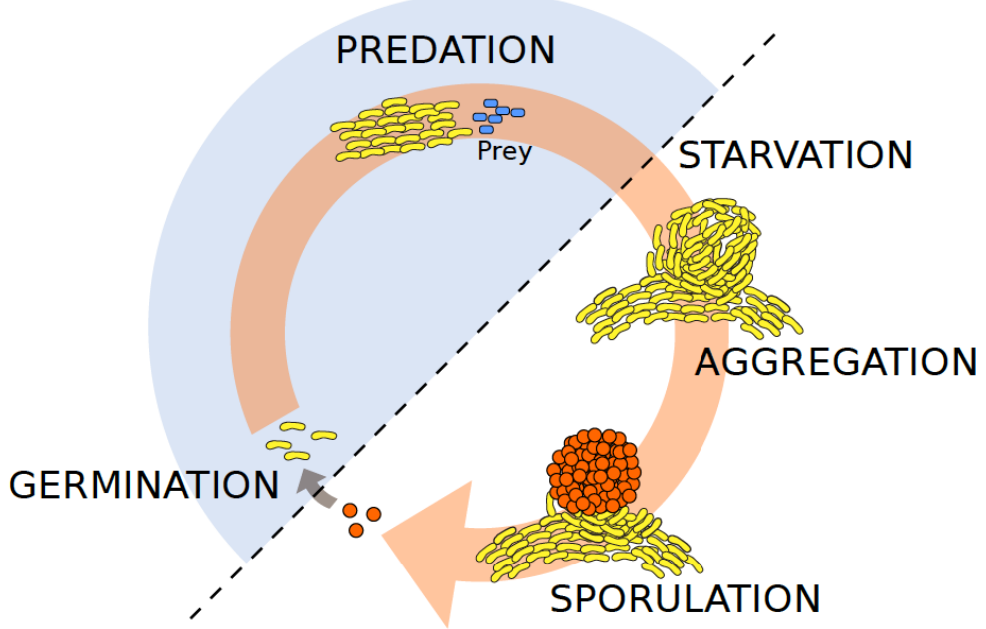
Figure 1. Schematic life cycle of the social myxobacterium Myxoccocus xanthus . The life cycle of M. xanthus (yellow-pigmented rods) is governed by the availability of food sources such as organic compounds or bacterial prey cells (blue rods). Under ambient nutrient-rich conditions, M. xanthus cells engage in group-level predation for feeding and rely on different (both social and solitary) motility systems. It is in this vegetative stage (highlighted as shaded blue half-circle), that cells are most susceptible to phage adsorption, such as shown for Mx1 [34]. In contrast, under nutrient limitations, M. xanthus kin groups undergo multicellular development that typically involves fruiting body formation in which a fraction of cells forms stress-resistant spores (orange spheres). Phages are unable to infect their hosts in the spore stage, but may infect cells after spores have germinated [34]. In contrast to their bacterial hosts, very little is known about the myxophages. As is true for most